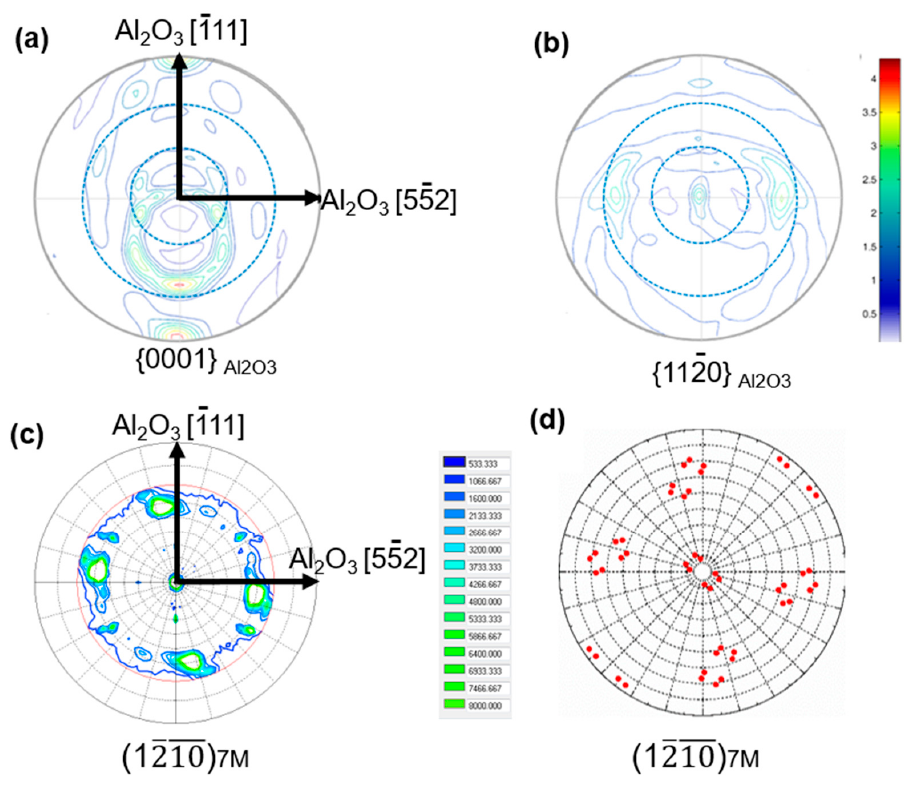
Figure 5. ( a ) {0001} Al2O3 and ( b ) {1120} Al2O3 pole figures of the Al 2 O 3 substrate, ( c ) measured and ( d ) theoretically calculated {1 2 10 } 7M pole figures of the Ni 51.0 Mn 27.5 Ga 21.5 thin films with thicknesses of 600